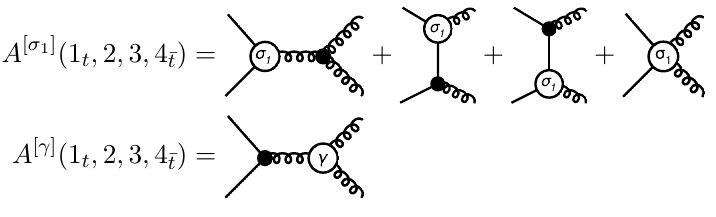
Figure 7 . The Feynman diagrams contributing to the tree-level amplitudes appearing the pole structure of the one-loop t (cid:22) tgg amplitudes in 6 2 (cid:15) dimensions. Solid vertices correspond to the (cid:0) usual QCD interactions while the open vertices are those resulting from the corresponding dimension 6 six operators in of eq. (5.18) QCD L